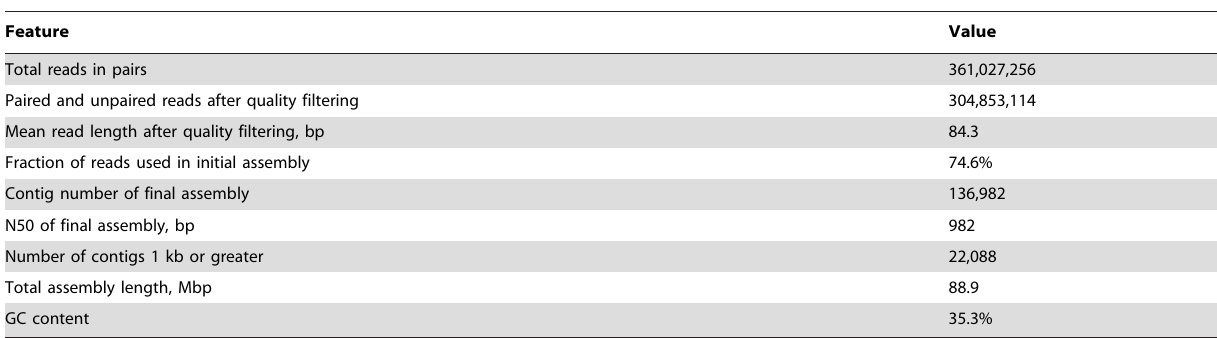
Table 1. Sequencing and assembly statistics.